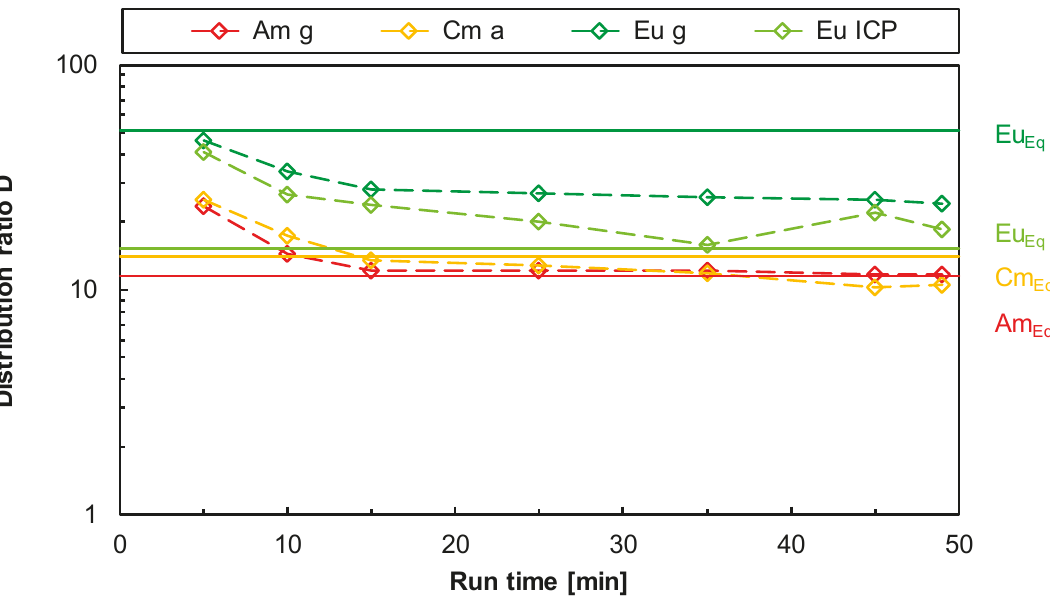
Figure 2. Am, Cm, and Eu distribution ratios as a function of the experimental run time (data points) and equilibrium values (horizontal lines) in the extraction section single centrifugal contactor test. “g”, “a”, and “ICP” indicate values measured by gamma and alpha spectrometry as well as inductively coupled plasma mass spectrometry (ICP-MS),